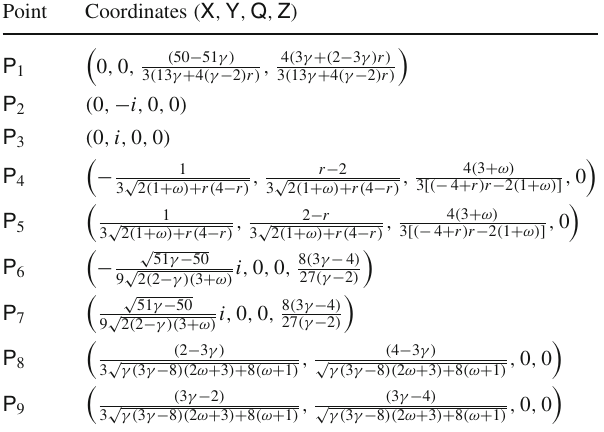
Table 2 The fixed point solutions of the autonomous system (49)–(52) Point Coordinates ( X , Y , Q , Z